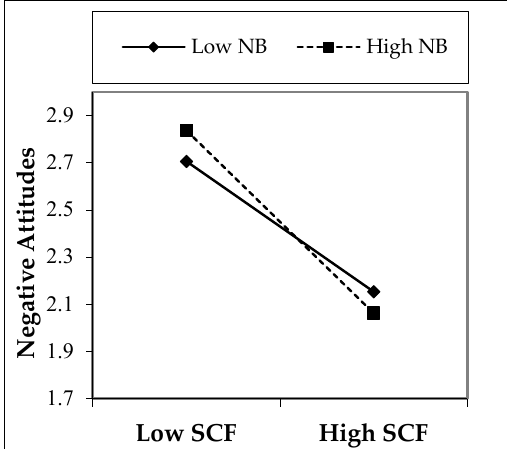
Figure 3. Interaction effect of SCF and NB on negative attitudes.